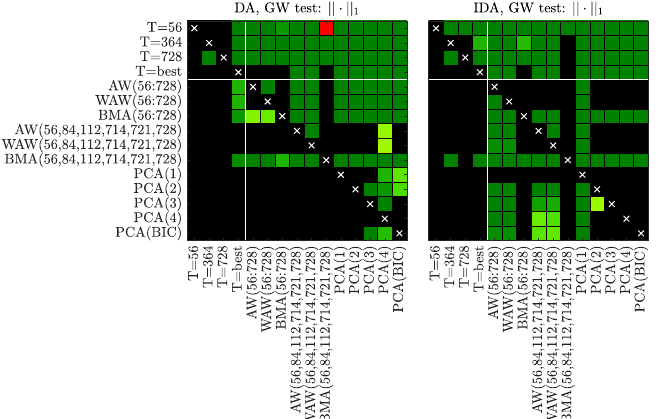
Figure 6. Results of the conditional predictive ability (CPA) test [52] for forecasts of all considered models. We use a heat map to indicate the range of the p -values—the closer they are to zero ( → dark green) the more significant is the difference between the forecasts of a model on the X -axis (better) and the forecasts of a model on the Y -axis